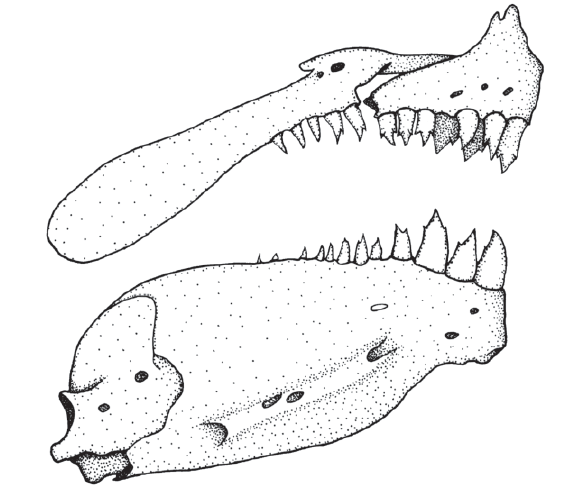
Fig. 6 . Lophiobrycon weitzmani , paratype, jaws and denti- tion of adult male, lateral view, anterior at right. LIRP 4339, 24.3 mm SL, same locality data as in Figs. 1 and